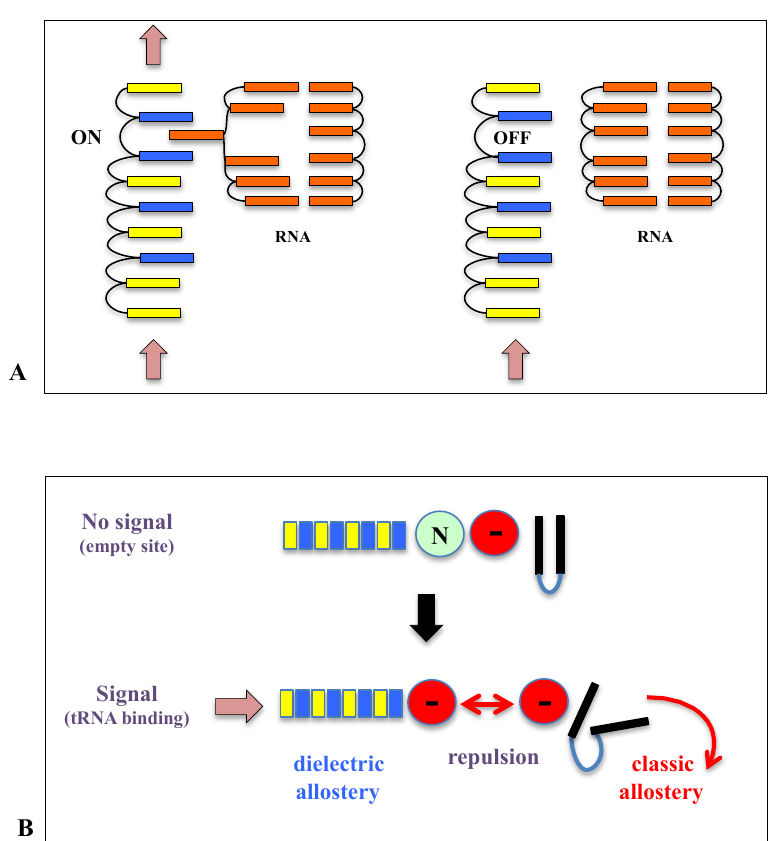
Figure 7. The schematic representation of possible allosteric mechanisms along and between r-proteins. ( A ) The hypothetical mechanism for a cooperative switch formed by the stacking of an rRNA base in the r-protein array of cation- π interactions. Basic (blue), aromatic residues (yellow) or rRNA base (orange) are proposed to transfer charges or electrostatic perturbation (vertical arrow). The signal can be propagated if the rRNA base is stacked in the array and the switch is ON. The signal cannot be propagated if the base is stacked in the rRNA helix and the switch is OFF. ( B ) Summary of the possible combination of several allosteric mechanisms (dielectric and classic). Dielectric allostery propagates an electrostatic perturbation through array of basic (blue) and aromatic (yellow) residues (for example, coming from the binding of tRNA). This may transiently change the charge of a distant neutral residue (N) into a negative one (-) thus inducing a conformational change triggered by a local charge repulsion (or